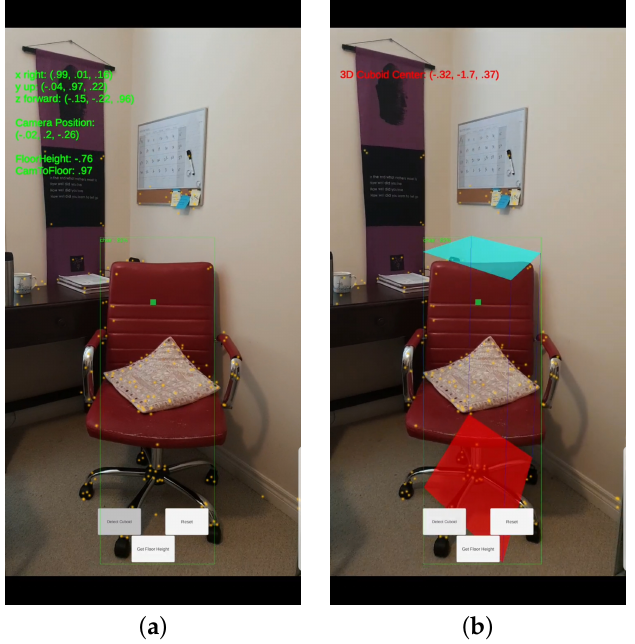
Figure 2. Screenshots of the mobile application developed based on our framework. ( a ) The 2D bounding box (green box) of the detected object using SSD-MobileNetV1, ( b ) the final 3D cuboid computed (light blue and red surfaces represent the top and bottom of the cuboid, respectively, and are joined with dark blue colored line segments) from the 2D bounding